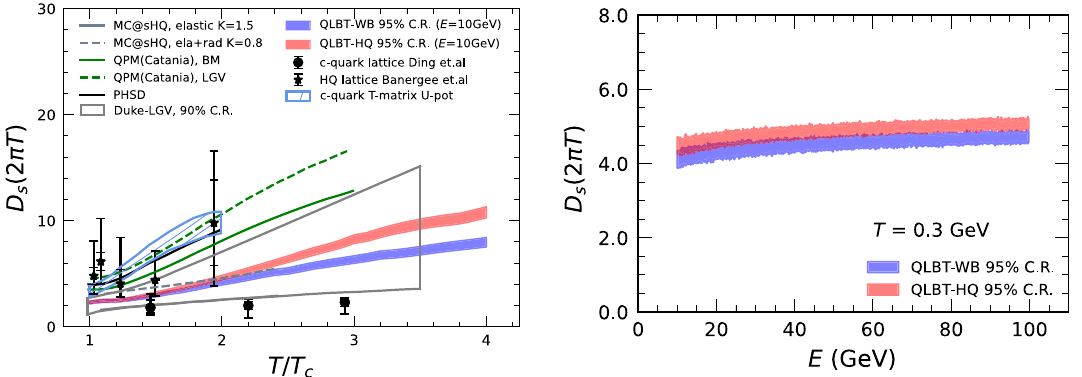
Fig. 9 Temperature(Left)andenergy(Right)dependentcharmquarkdiffusioncoefficient D s obtainedusingtwodifferent g ( T ) extractedfromWB andHQlatticeQCDdata,comparedtotheresultsfromdifferentlatticeQCDcalculations[127,128]andphenomenologicalstudies[89,108,129–131]